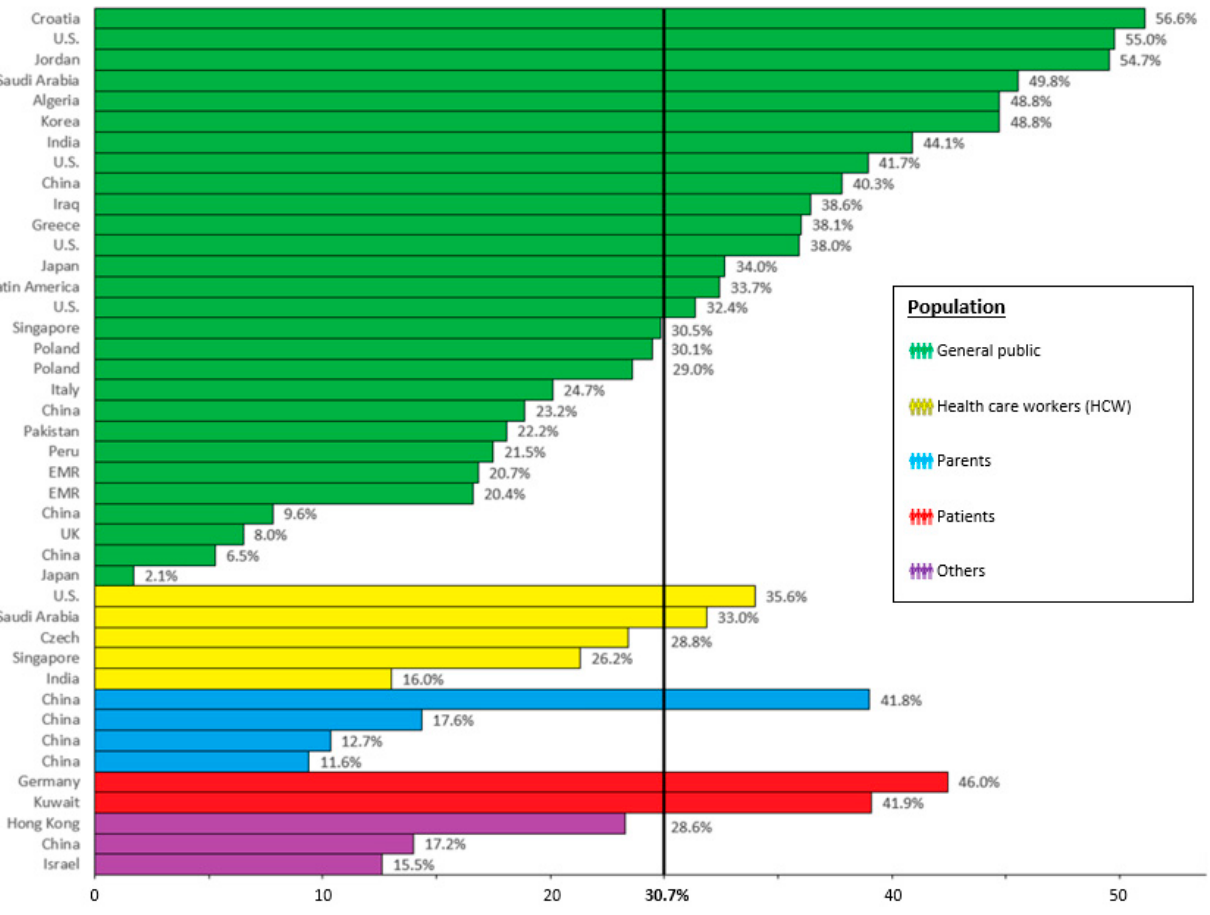
Figure 2. COVID-19 booster vaccine hesitancy (CBVH) rate by study population and geographical region compared to the average CBVH rate of 30.7% across all included studies. region compared to the average CBVH rate of 30.7% across all included